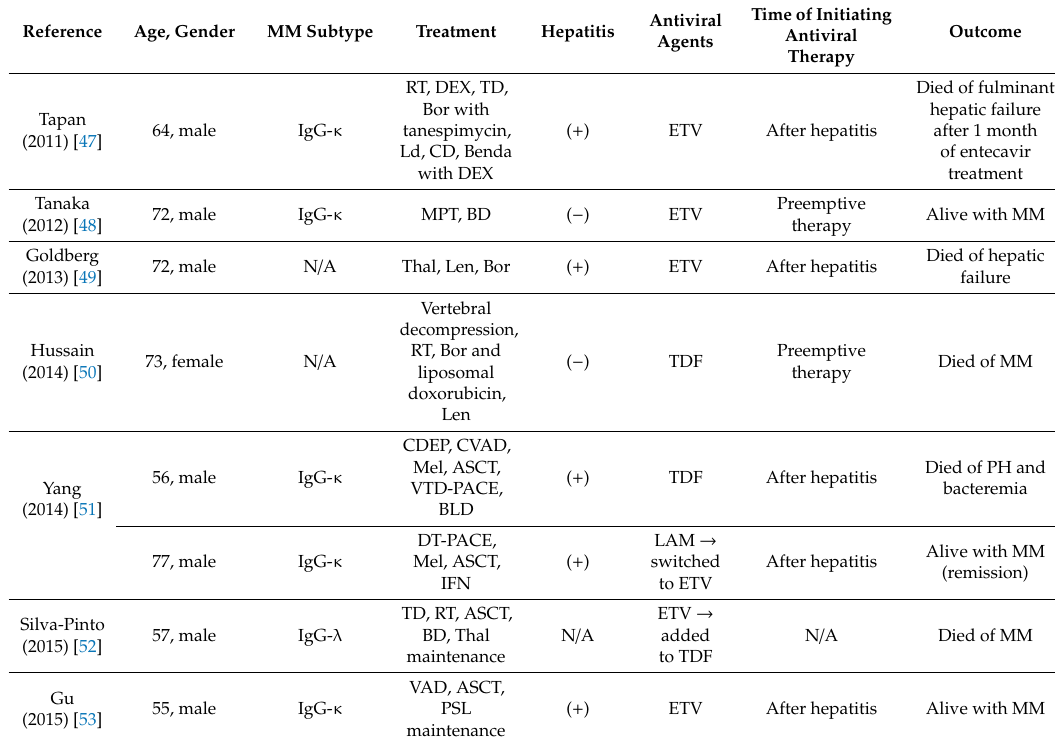
Table 4. HBV reactivation in MM patients (case